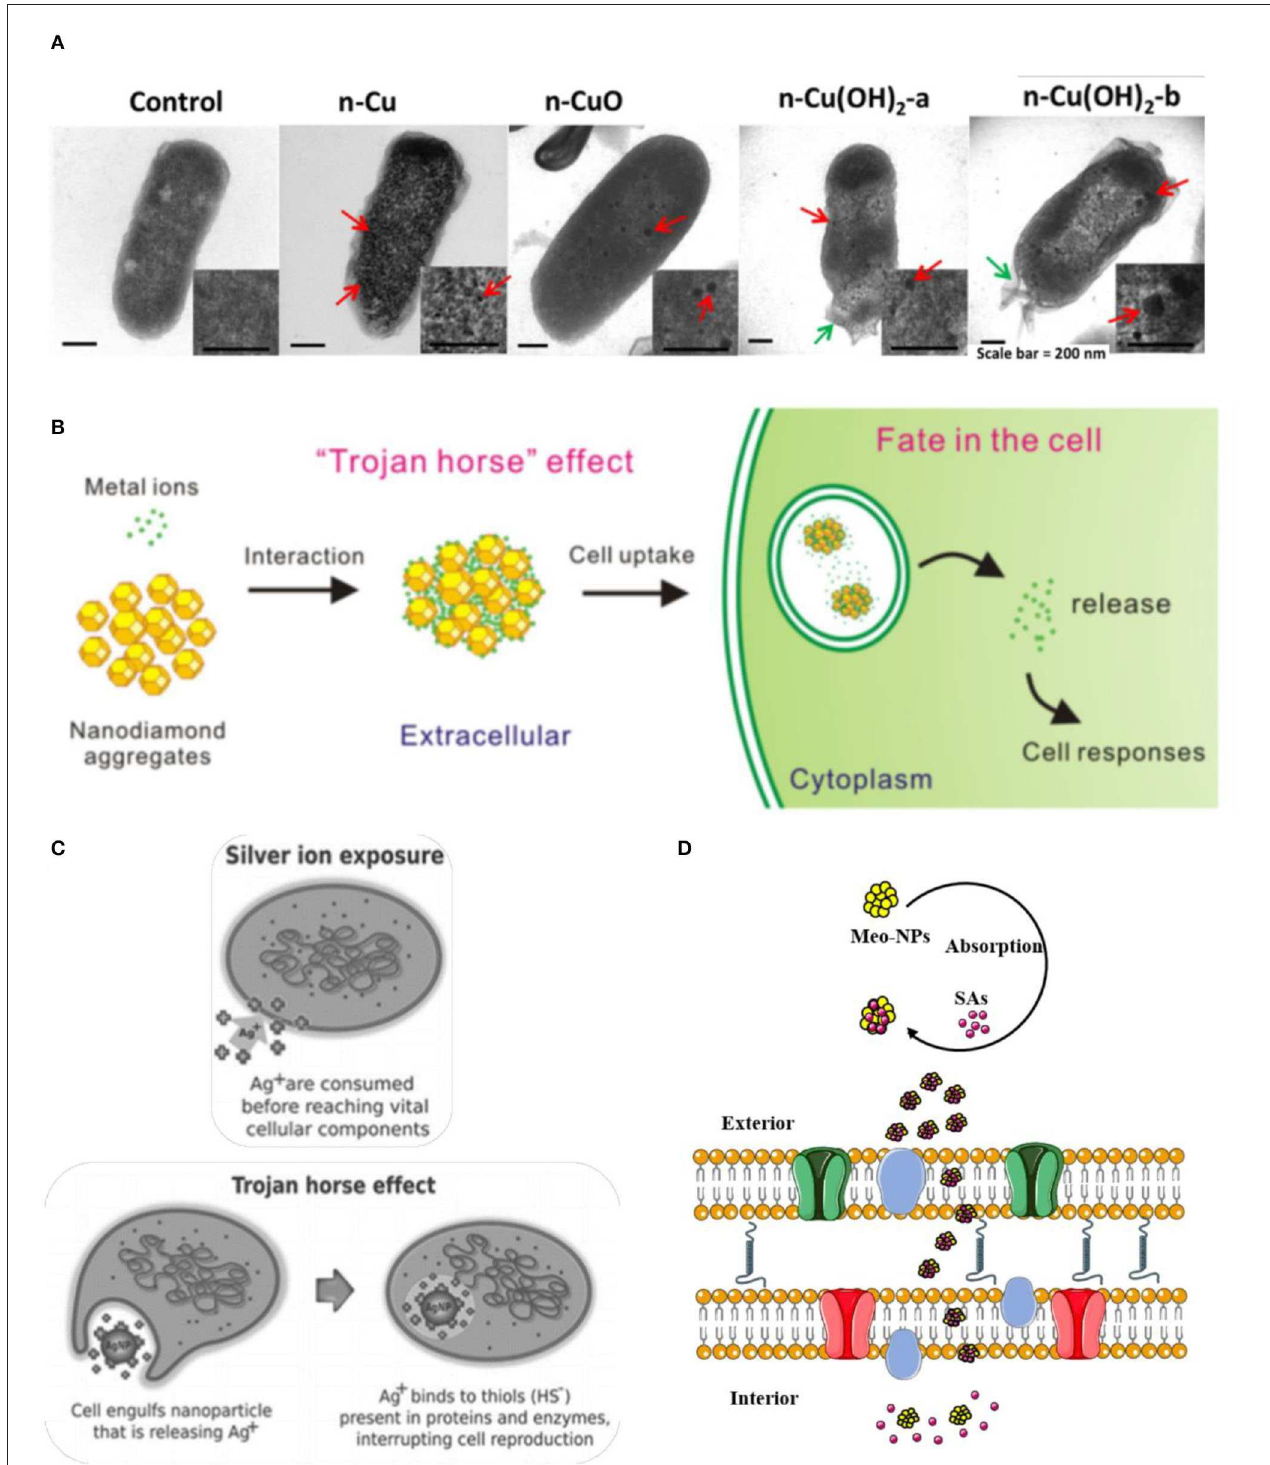
FIGURE 7 | The potential mechanism of Trojan-horse type. (A) High—resolution transmission electron microscopy (TEM) micrographs of E. coli cells treated with nano Cu to CuO and Cu(OH) 2. Red arrows indicated Cu particles; green arrows indicate membrane damage (Kaweeteerawat et al., 2015). (B) The scheme of absorption of metal ions on Nanodiamond (NDs) led to cellular toxicity (Zhu et al., 2015). (C) Comparison of silver ion and AgNP exposure, the toxicity of AgNP are more toxic than